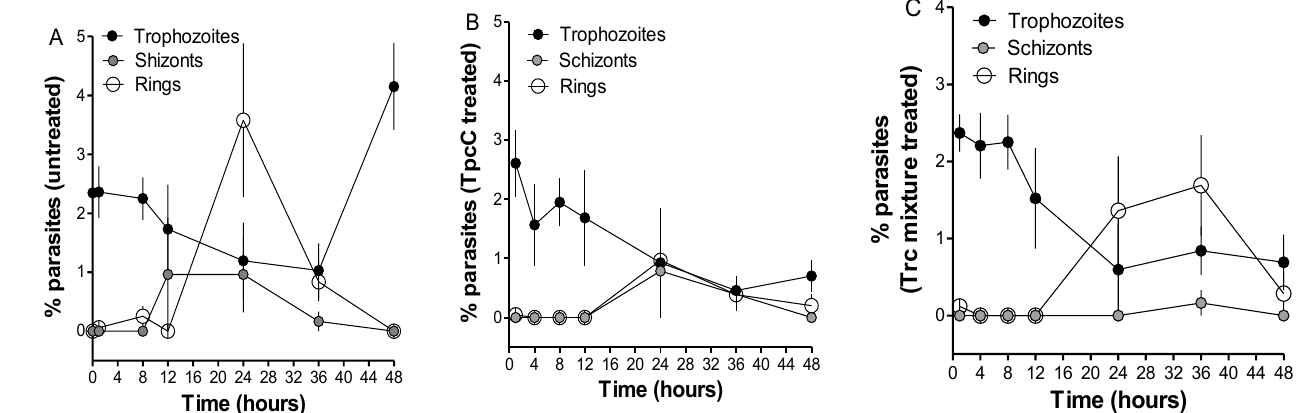
Figure 2. Distribution of trophozoite, schizont and ring parasite stages over time from 0 to 48 h following treatment of synchronized P. falciparum D10 cultures at trophozoite stage incubated without (control) ( A ), with 200 nM of TpcC ( B ) or 200 ng/mL Trc mixture ( C ). Each data point represents the mean ± SEM of parasite counts made within 8–13 regions on the microscope slide from two cultures of each treatment.